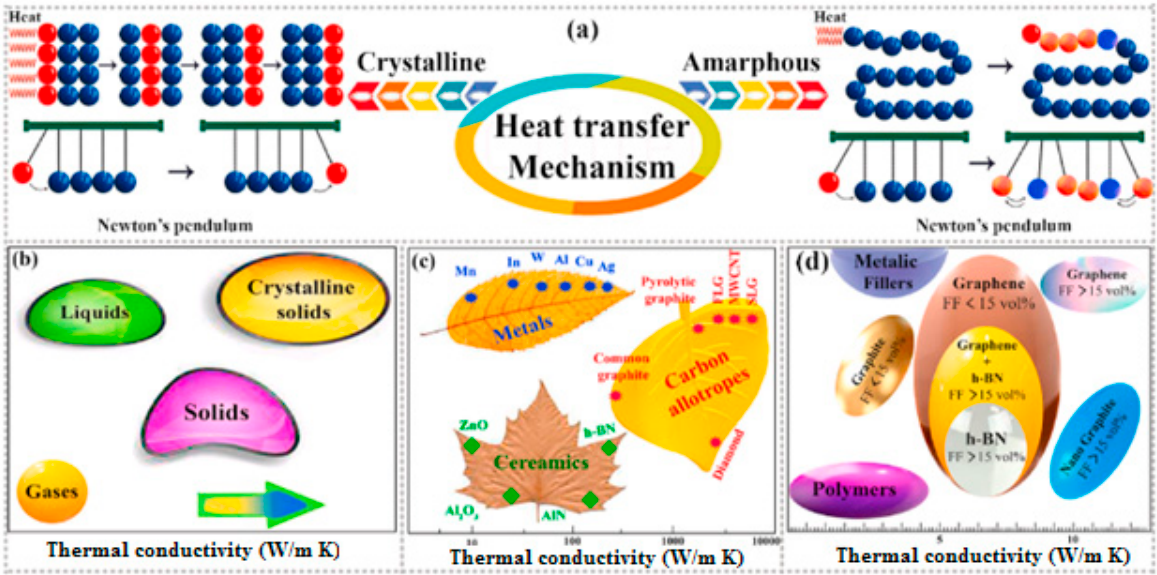
Figure 65. Schematic demonstration of ( a ) heat transfer mechanism in crystalline and amorphous polymers, ( b ) K levels in different phases of materials, ( c ) classifying common thermally conductive solid materials for various filler materials and ( d ) categorizing various filler-reinforced PMCs regarding their thermal conductivities, adapted with permission from Ref. [189]. Copyright © 2022 Elsevier Ltd. Table 2. Thermal conductivity of commonly used